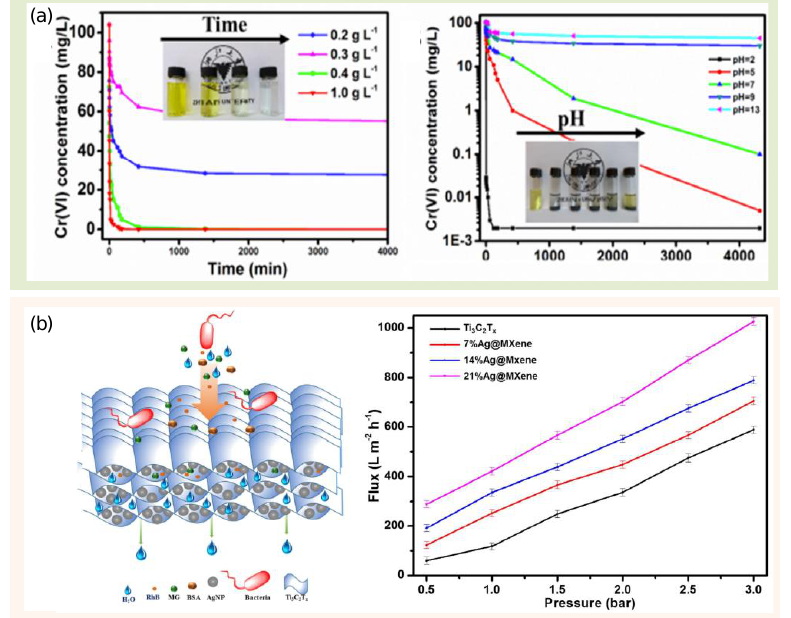
Figure 9. The applications of MXenes in environmental remediation. ( a ) Dosage effect of the Ti 3 C 2 T x − 10% nanosheets on removing Cr (VI) in 400 mL of 104 mg L −1 solution (pH 5.0) (left-hand side panel) and the insert panel is the corresponding photograph with elongation of time, indicating the change in color in the case of 0.4 g L −1 Ti 3 C 2 T x − 10% nanosheets. Removal of Cr (VI) in 400 mL of 104 mg L −1 solution (Ti 3 C 2 T x − 10% nanosheets concentration: 0.4 g L −1 ) dependent on pH (right-hand side panel), and the insert is the final solution color at different pH [107]. ( b ) MXenes/silver nanoparticles (AgNPs) composite for water permeation with anti-fouling properties is schematically shown on the left-hand side panel [109]. The pure water flux of Ti 3 C 2 T x and MXenes/AgNPs composite membranes is shown in the right-hand side panel [109].